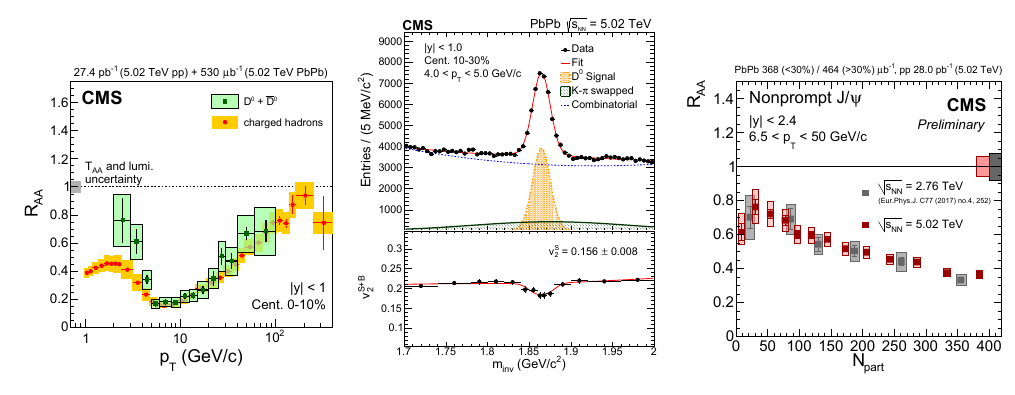
Figure 3. Left: R AA of prompt D 0 mesons and charged hadrons in pp and PbPb collisions at √ s NN = 5 . 02TeV, as a function of p T [12]. Center: example of simultaneous fit of the invariant mass spectrum and the v 2 , for the extraction of the v 2 of prompt D 0 mesons in PbPb collisions at √ s NN = 5 . 02TeV [13]. Right: R AA of nonprompt J /ψ mesons as a function of the number of participants to the collision, at √ s NN = 2 . 76 [2] and 5.02TeV